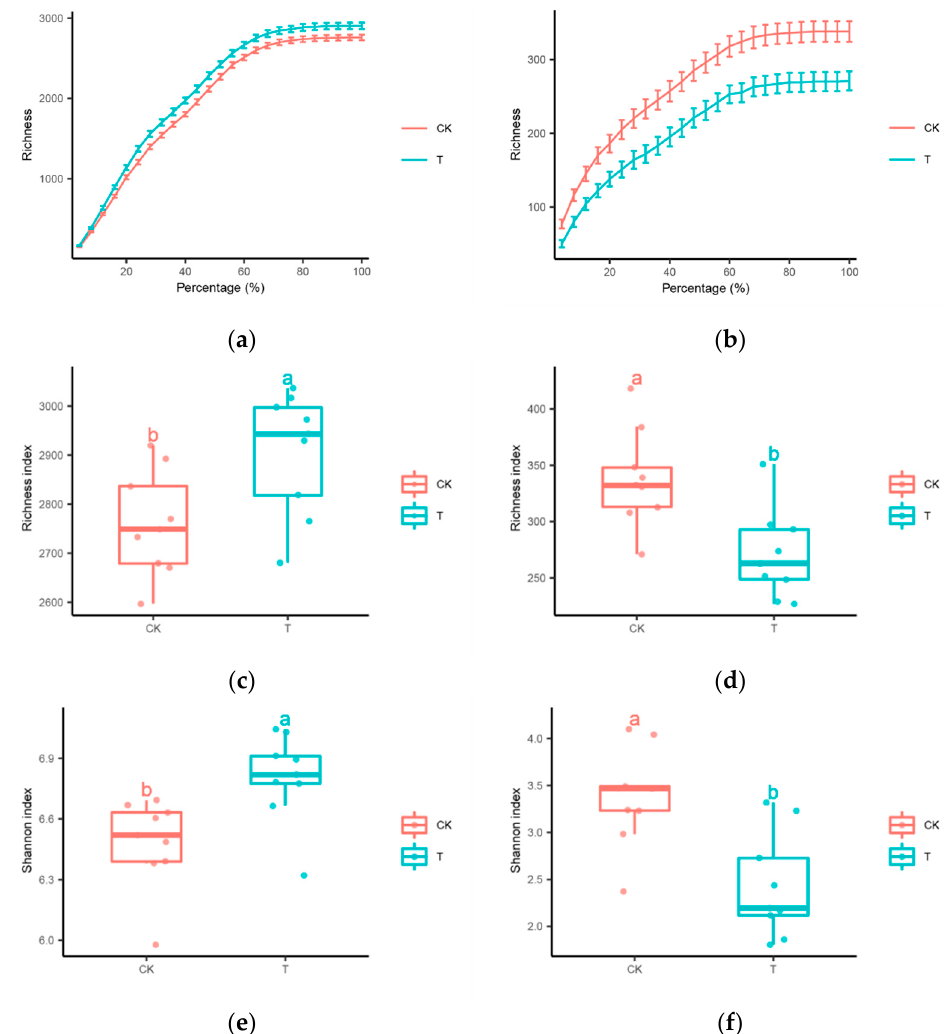
Figure 1. Alpha diversity of the rhizosphere microbiome associated with cucumber plants in Streptomyces -inoculated soil (T) and uninoculated control soil (CK). ( a ) Rarefaction curves of bacteria; ( b ) rarefaction curves of fungi; ( c ) richness index of bacteria; ( d ) richness index of fungi; ( e ) Shannon index of bacteria; ( f ) Shannon index of fungi. The horizontal bars within boxes represent the medians. The tops and bottoms of boxes represent the 75th and 25th percentiles, respectively. The upper and lower whiskers extend to data no more than 1.5× the interquartile range from the upper edge and lower edge of the box, respectively. Different letters above boxes indicate significant differences at p < 0.05.